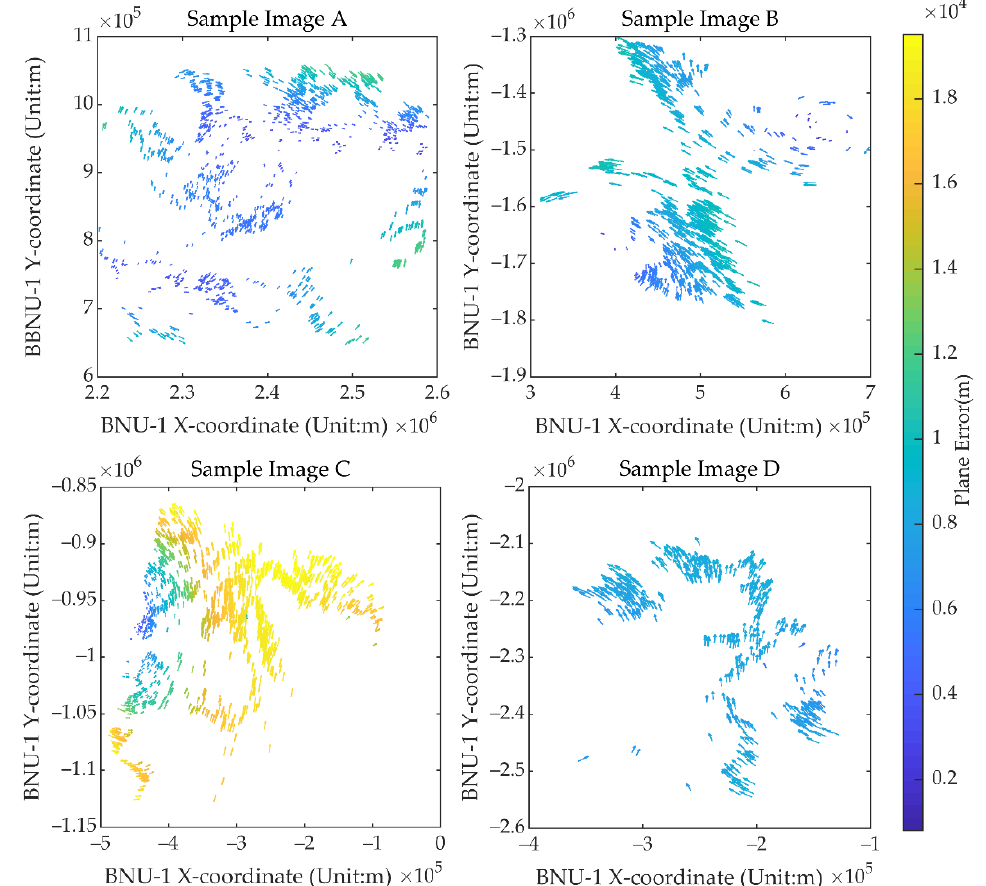
Figure 4. Displacement vectors of the CPs for the four sample BNU-1 L1A images and the corresponding MODIS images in Figure 3. The vectors start and end at the CPs’ coordinates in polar stereographic projection on the BNU-1 L1A images and the corresponding MODIS images, respectively. The color of the vectors represents the error magnitude according to the legend.